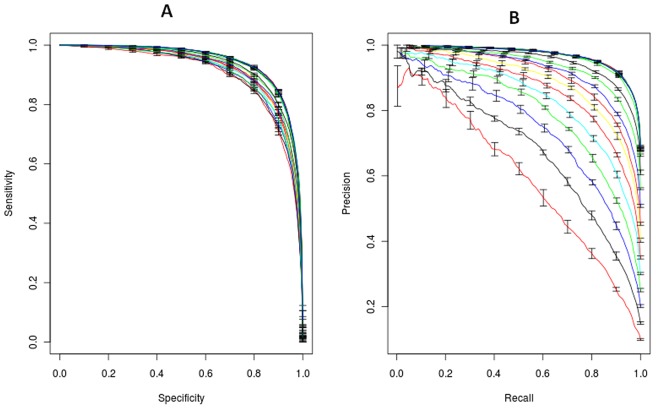
ROCs and precision-recall curves with different Ki thresholds using RF.(A) ROCs (B) precision-recall curves. The auPRCs drop with the decreasing of Ki thresholds. However, the varying trend of auROCs is consistent with that of auPRCs.